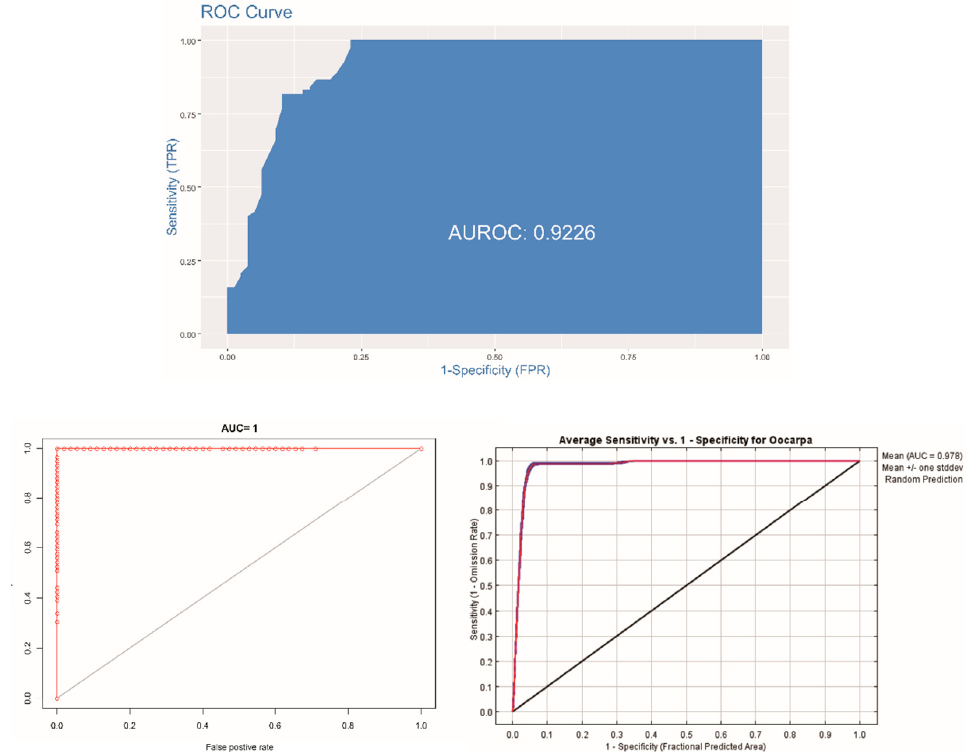
Figure 9. AUC curves of Pinus oocarpa using logistic regression, random forest, and MaxEnt.